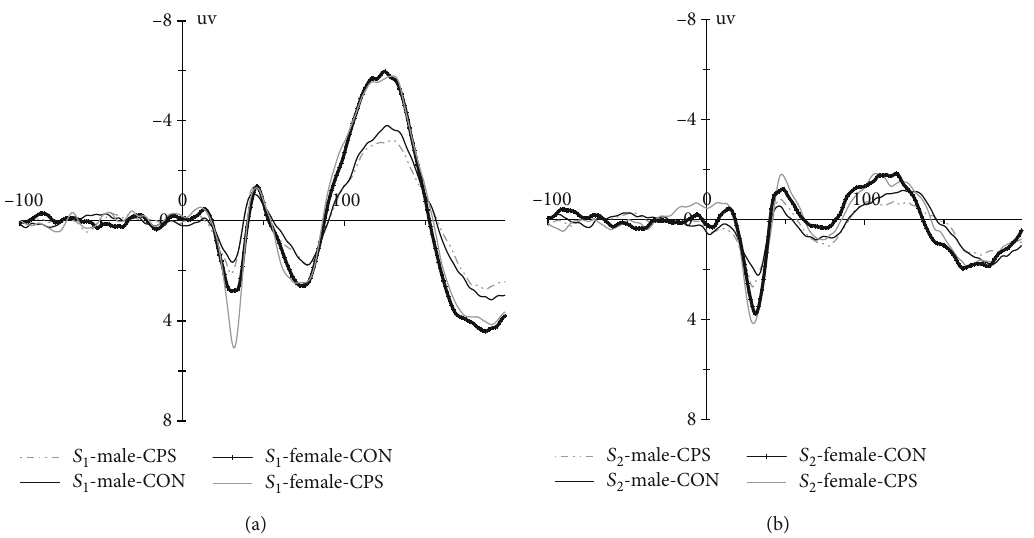
Figure 1: Grand averaged auditory evoked potential waves (C experimental sessions (CON: control condition; CPS: cold pressor stress treatment) ( bandpass filter = 10 – 50 Hz ). Table 3: Amplitudes, latencies, gating ratios, and di ff erences for P